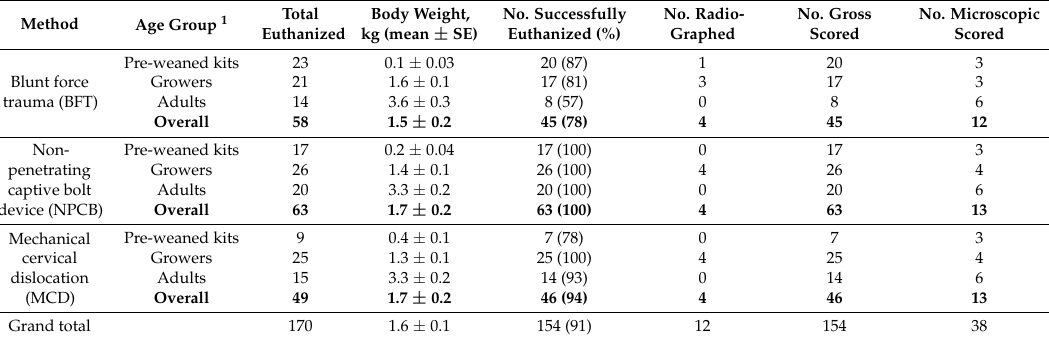
Table 2. Number of cull rabbits per age group euthanized by different methods included in each stage of the